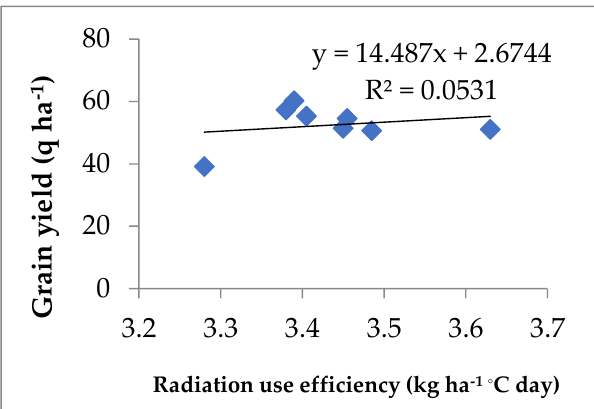
Figure 3. Linear regression equation to find the effect of agrometeorological indices on grain yield of hybrid maize.